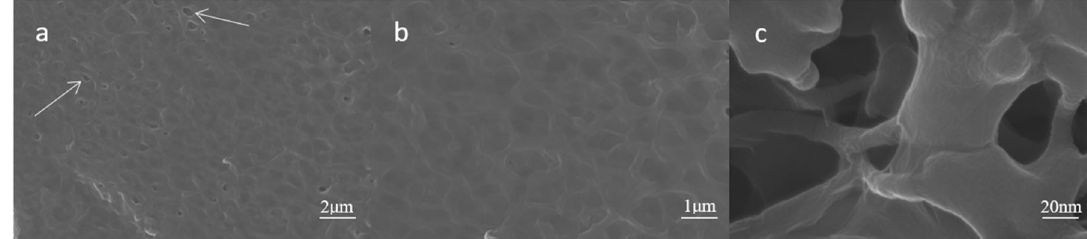
Fig. 3 PEEK sulfonated after 10 min of specimen sedimentary GO surface morphology of ( a ) 5K; ( b ) 10K; ( c ) 50K magni fi